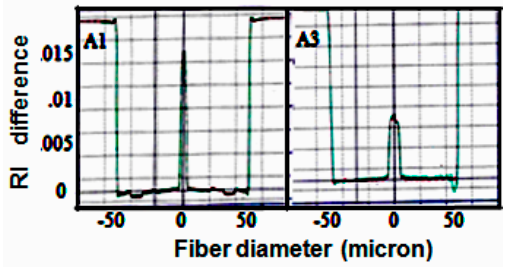
Figure 7. Refractive-index profiles of two erbium-doped fibers (EDFs): phase-separated ( A1 ) and non-phase-separated ( A3 ).